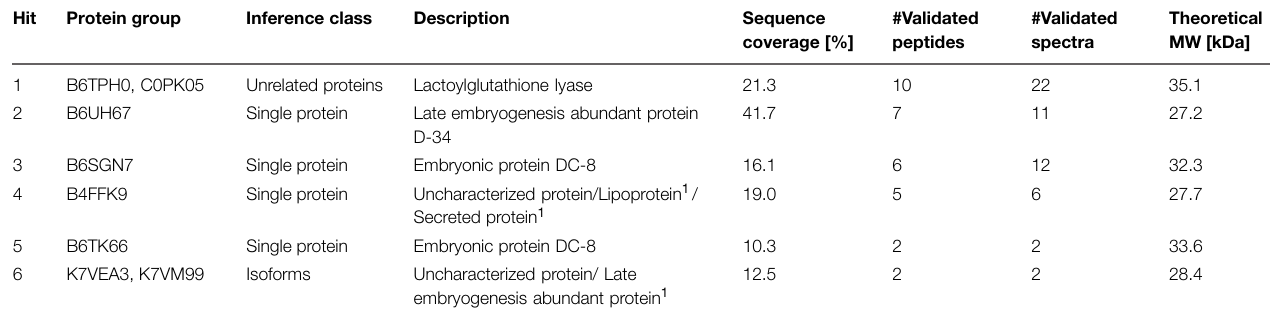
TABLE 2 | NanoESI-LC-MS/MS based identification of proteins from 2D gel, spot 1, after POD activity staining (Data analysis with LabKey). Hit Protein